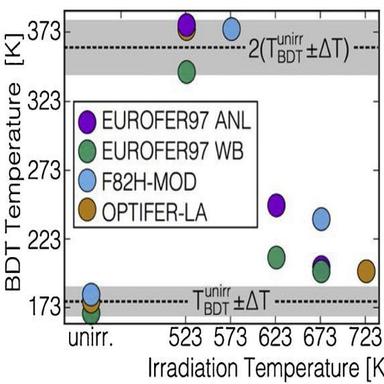
Temperatures of brittle to ductile transitions (BDT) in several fusion steels. A model based on the analysis of screw dislocation mobility suggests that the BDT temperature doubles if irradiation is performed at relatively low temperature.